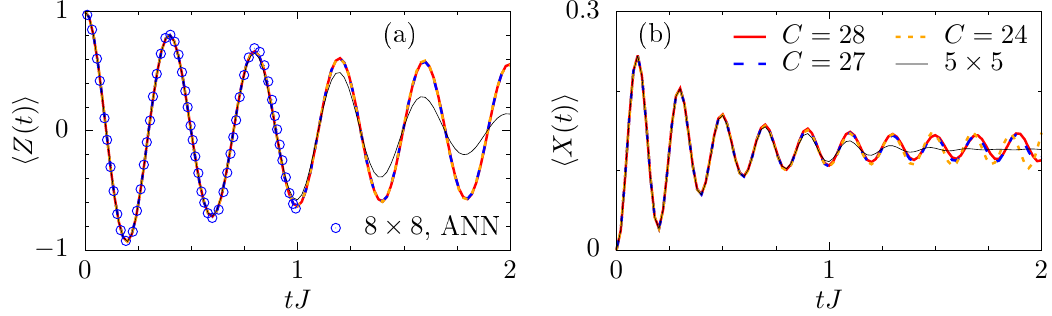
Figure 6: Dynamics of the (a) longitudinal magnetization 〈 Z ( t ) 〉 and (b) trans- verse magnetization 〈 X ( t ) 〉 , resulting from the initial state | ψ ( 0 ) 〉 = |↑〉 for a two- dimensional square lattice with g = 2.63 g . Data obtained by NLCE for expansion c orders C = 24,27,28 are compared to a simulation of a 5 × 5 lattice with PBC. In